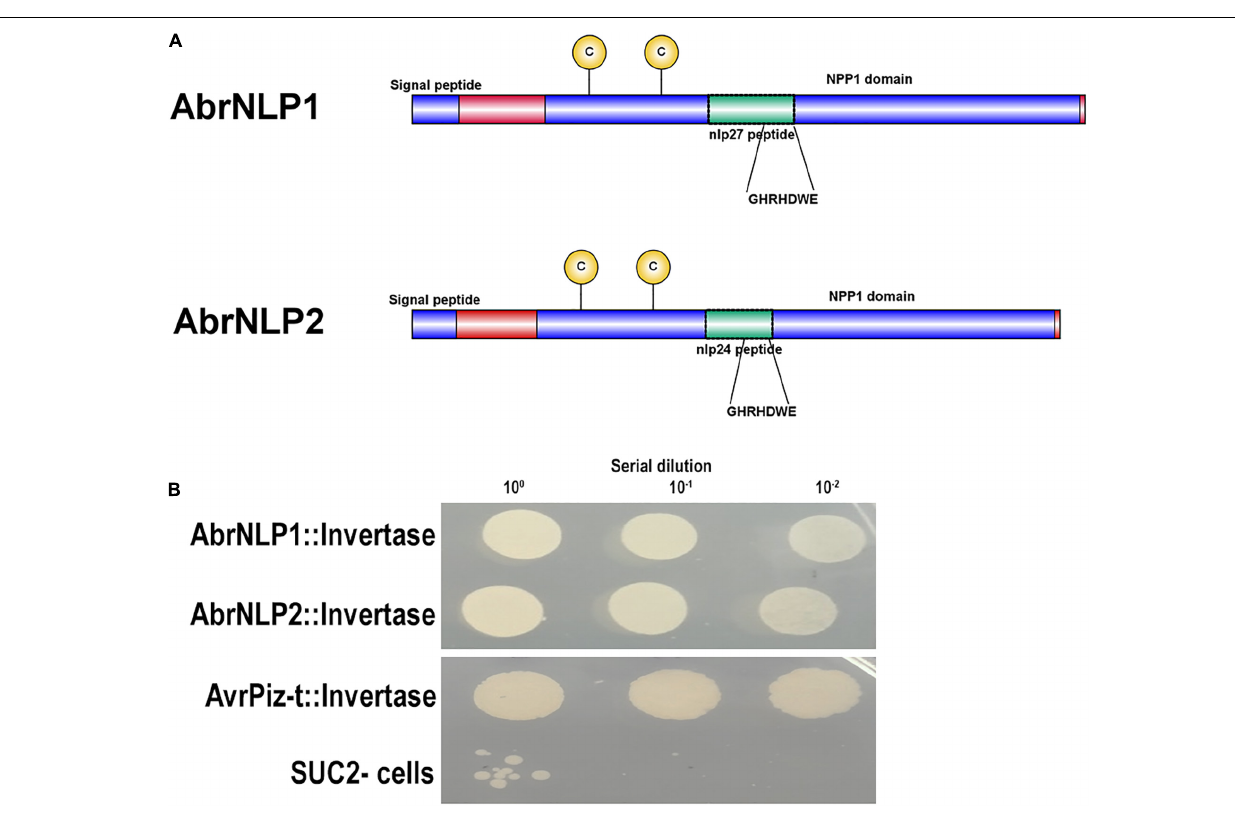
FIGURE 3 | AbrNLP1 and AbrNLP2 are secreted proteins as determined by the YST assay. (A) Schematic diagram of AbrNLP1 and AbrNLP2 indicating the signal peptides, NPP1 domains, and nlp24 and nlp27 conserved regions containing the heptapeptide motif GHRHDWE. (B) Yeast strain SUC2 − was transformed with AbrNLP1:Invertase, AbrNLP2:Invertase, and AvrPiz-t:Invertase, and a serial dilution of overnight cultures of the transformed strains were plated on medium containing sucrose with antimycin (1 µ g/ml). Untransformed SUC2 − was used as a negative control. AvrPiz-t, a known secretory protein from M. oryzae , was used as a positive control for the